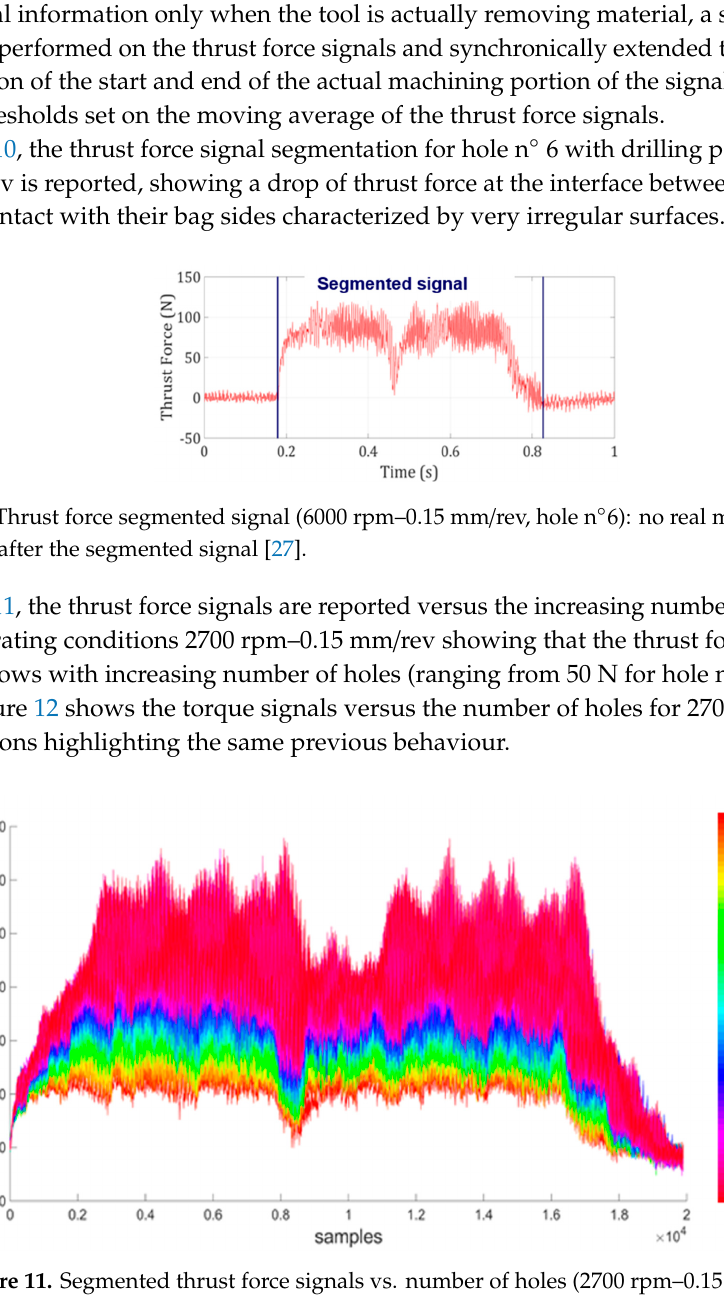
Figure 11. Segmented thrust force signals vs. number of holes (2700 rpm–0.15 mm/rev).